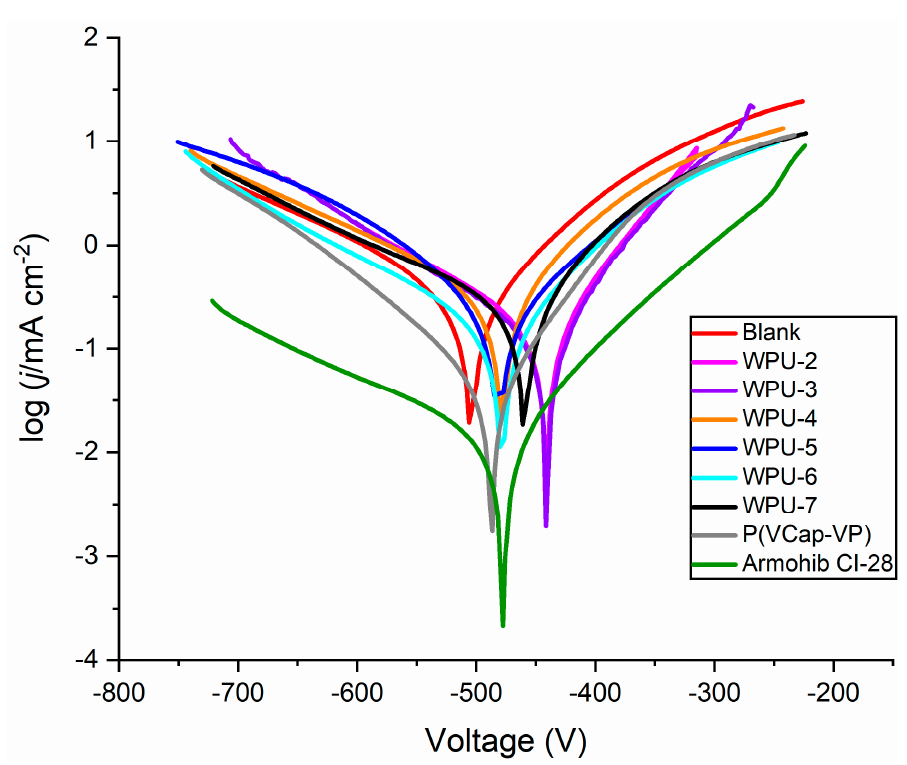
Figure 7. Tafel slopes for CS in 2M HCl solution without and with inhibitors (500 ppm).